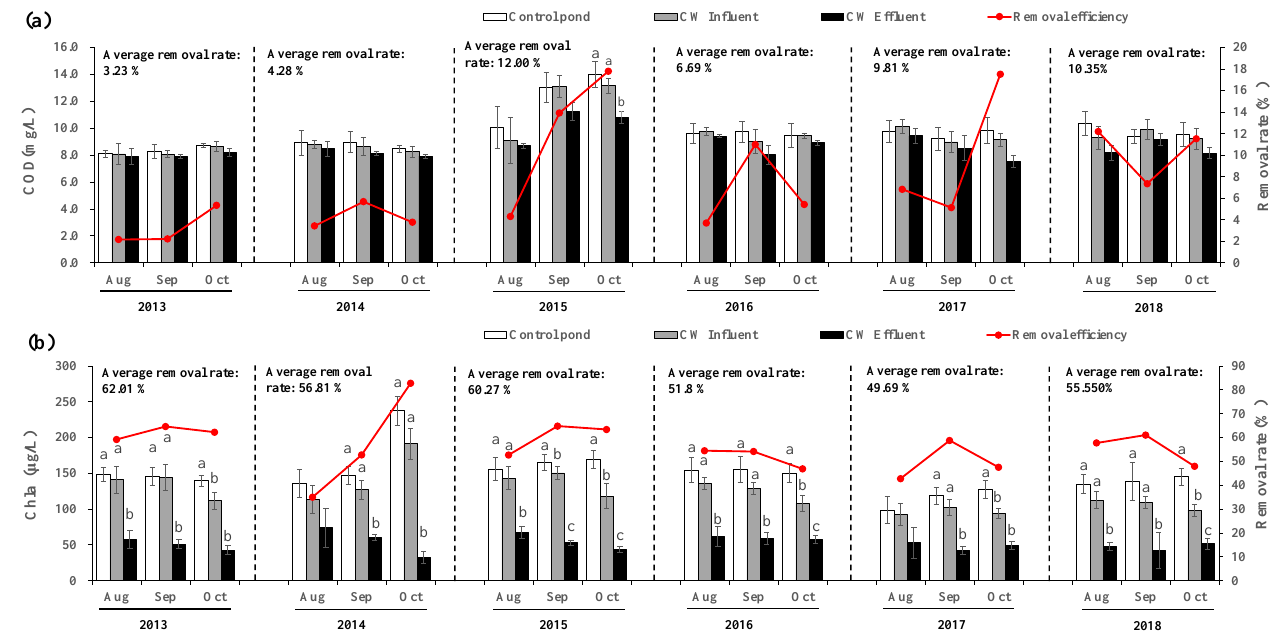
Figure 5. Concentrations of COD ( a ) and Chla ( b ) in water samples collected from the control pond and the inlet and outlet of CW, and the removal efficiency during the monitoring period. The value is expressed as mean ± SE ( n = 6), and different small letters in bar graphs indicate significant differences ( p < 0.05) among the control pond, CW influent and CW effluent.